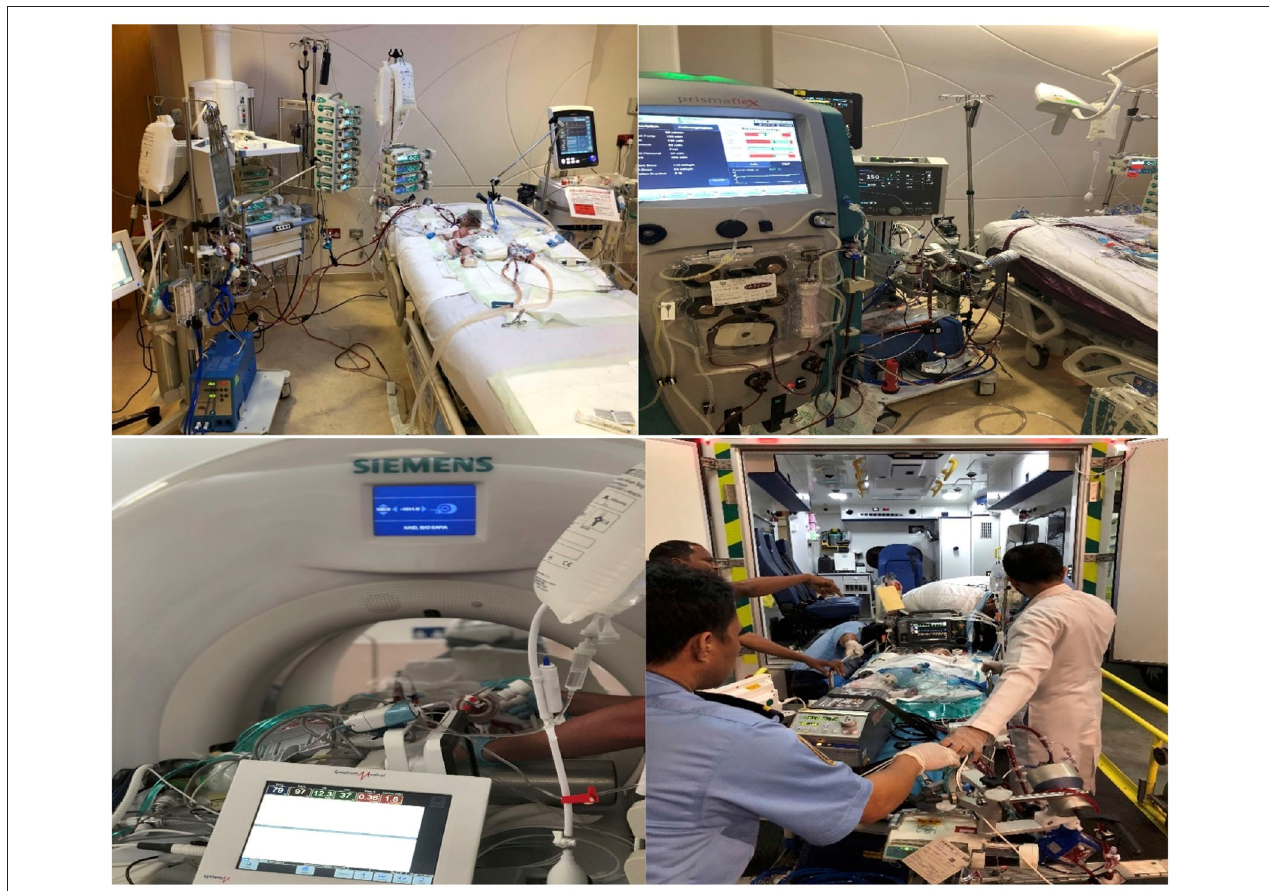
FIGURE 5 | First ECMO